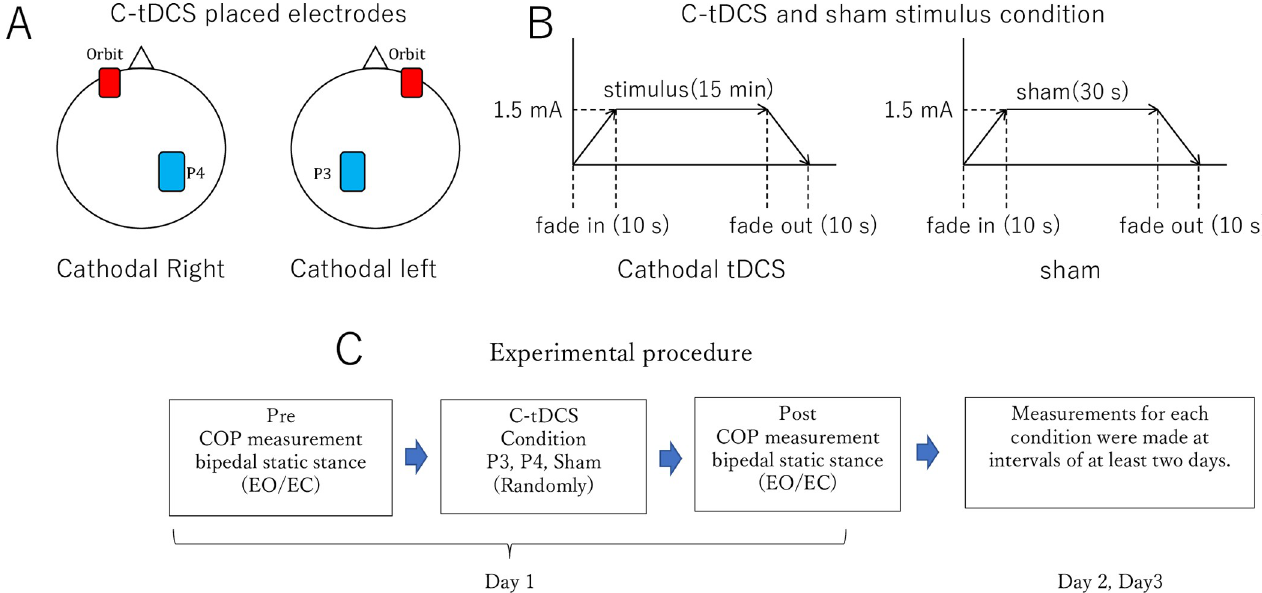
Fig 1. Experimental design. A. C-tDCS placed electrodes: cathodal electrode P4(right), P3(left) B. C-tDCS and sham stimulus condition, C. Experimental procedure.